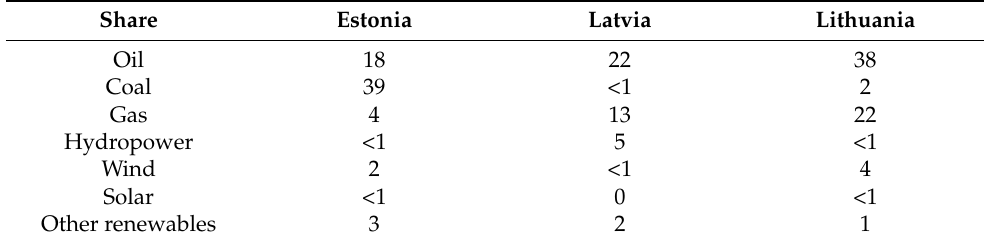
Table 3. Energy consumption by source (TWh) in the Baltic States in 2019 [38].